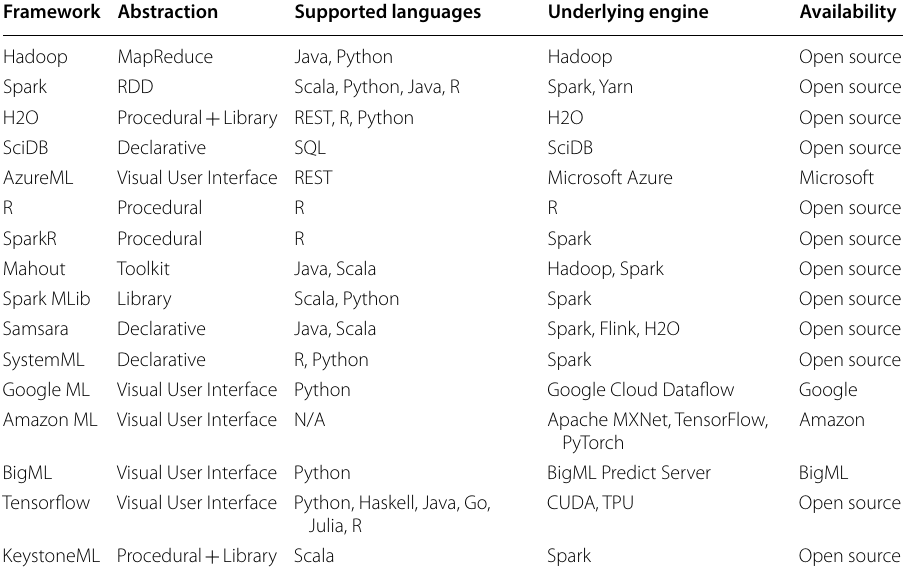
Table 1 Major feature of big data analysis frameworks Framework